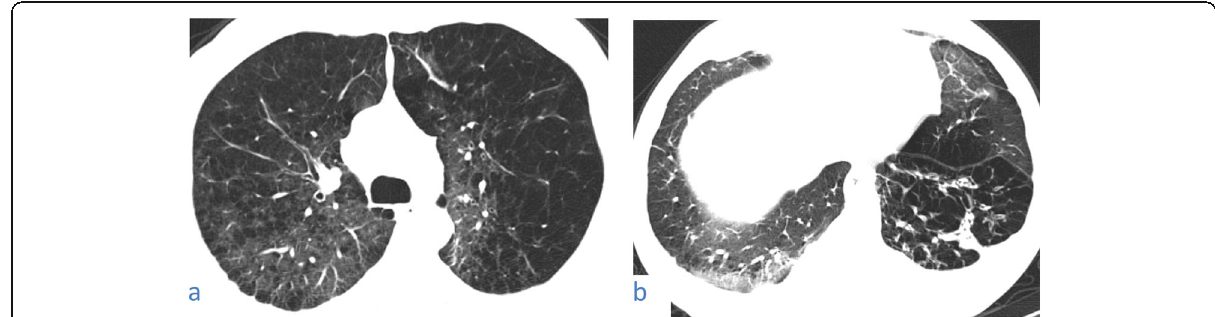
Fig. 21 A 48-year-old male smoker with COVID-19. Axial CT image ( a ) shows marked upper lobes centrilobular emphysema with subpleural and patchy ground glass opacification ( b ) shows right lower lobe peripheral ground glass opacity. Vascular thickening is seen related to lesions. Left lower lobe shows architectural distortion with fibrous